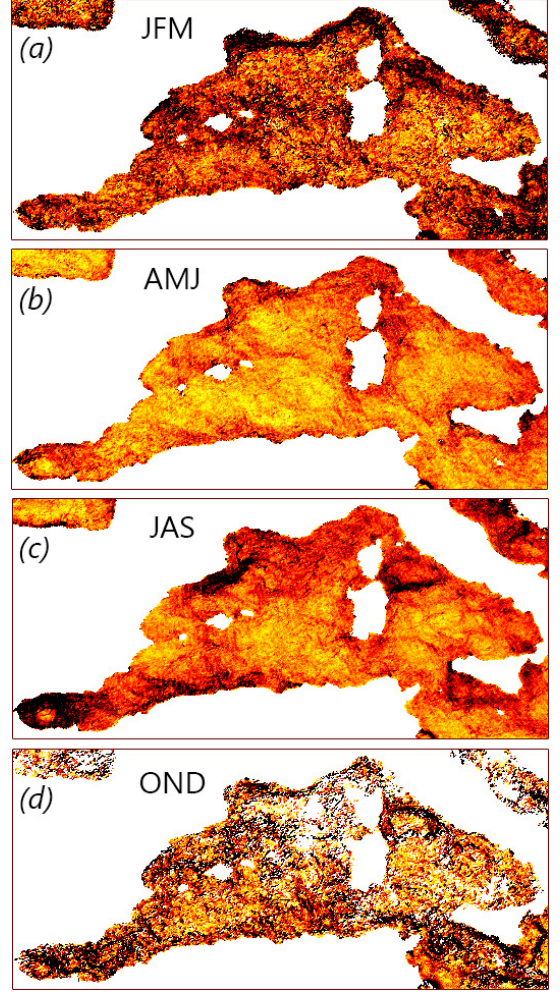
Figure 3. Seasonally averaged gradient of SST in 2009 As we can note, such generalized schemes of the SST gradient managed to capture the locations of the main circulation features in the region of interest. Thus, during the winter time (Figure 3(a)), there is a clear manifestation of the Northern Current in the Liguro-Provençal Basin and in the Gulf of Lion. During the spring time, the Northern Current manifestation is still visible in the vicinity of the Gulf of Lion (Figure 3(b)). In summer, one can note quite a broad meandering of the Northern Current in the Liguro-Provençal Basin; in the Balearic Sea, the current is getting narrow again (Figure 3(c)). Another area of sharp thermal contrasts during this season corresponds to a small gyre in the northern shallow part of the Tyrrhenian Sea.